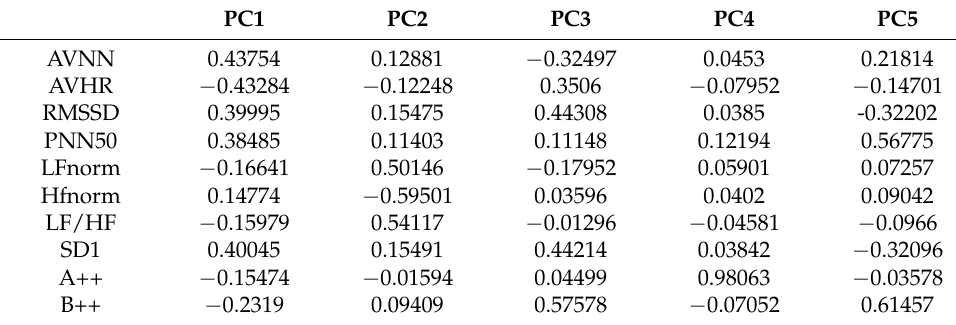
Figure 13. Principal component analysis results. Table 10. The factor loading matrix of PCA.